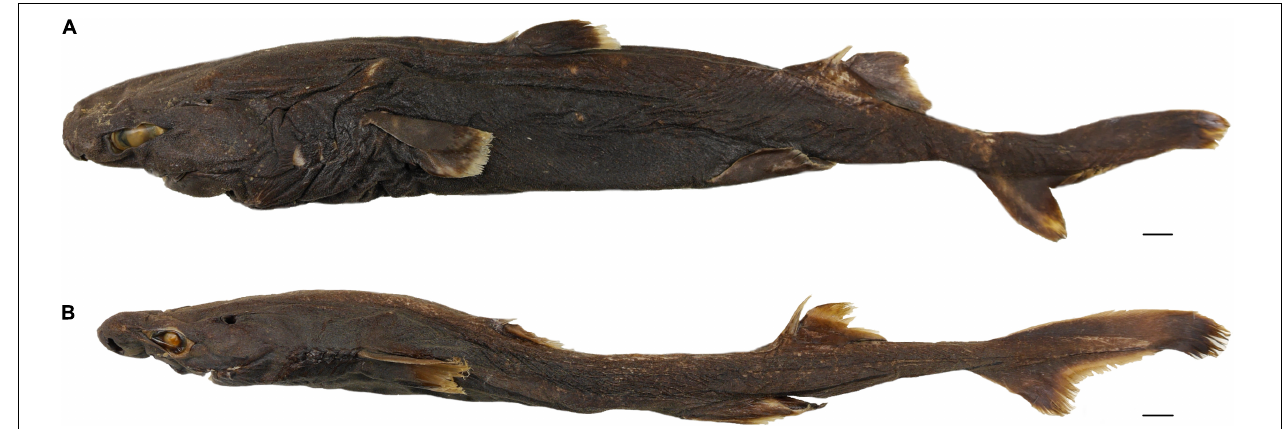
FIGURE 2 | Paratype images of (A) Etmopterus litvinovi (ZMH 24994) and (B) Etmopterus pycnolepis (ZMH 24995). Bars indicate 1 cm.